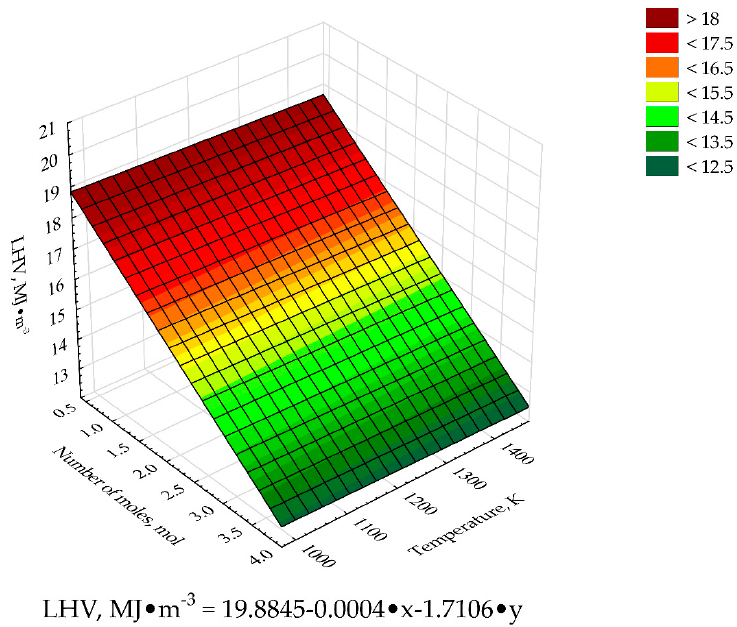
Figure 4. Effect of the number of moles of the gasification agent hydrogen (x) and temperature (y) on the heating value ( LHV ) of syngas.